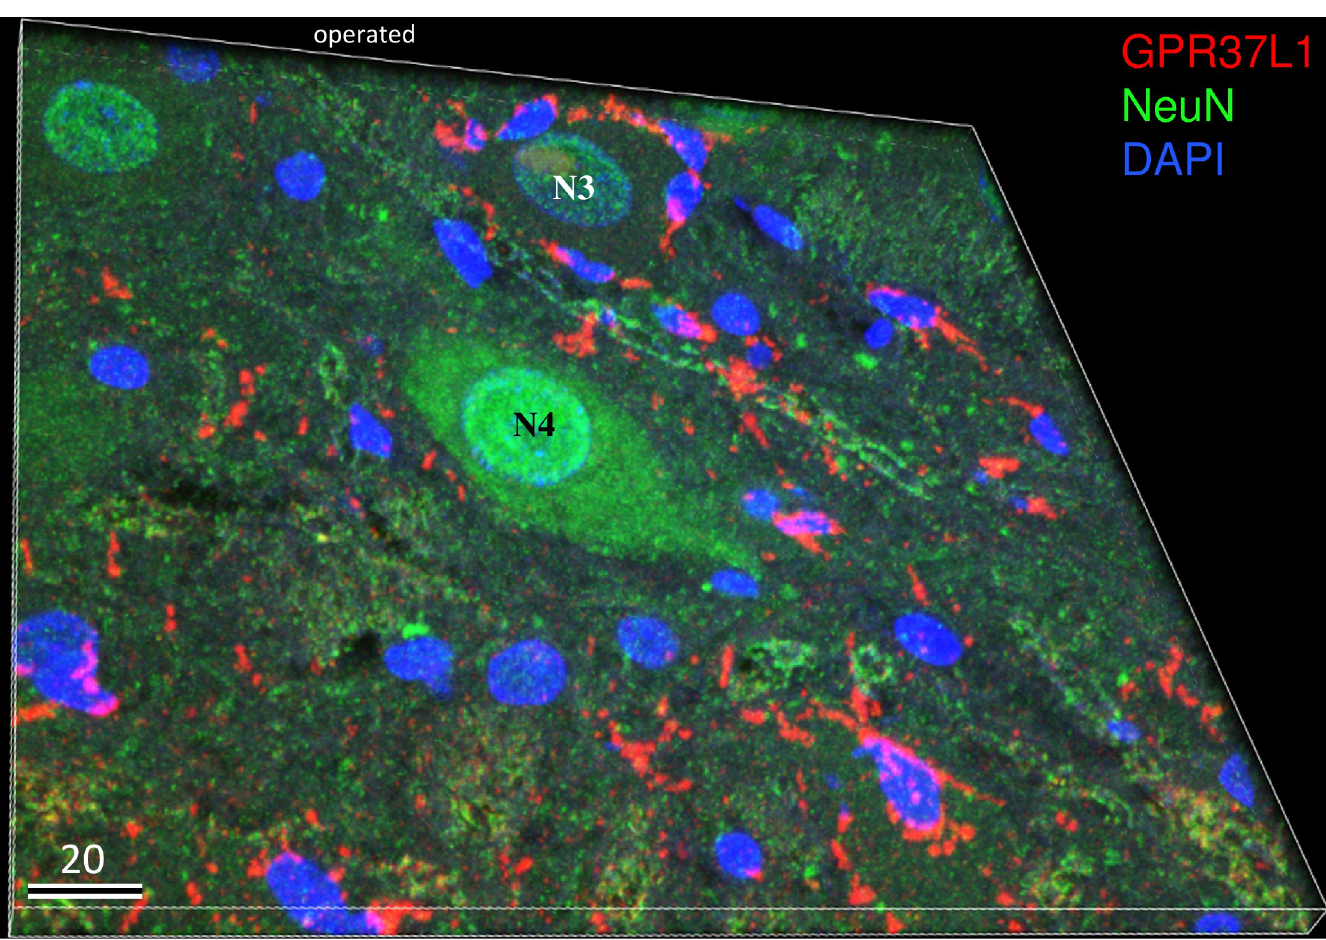
Fig 7. Three-dimensional image of triple-staining with GPR37L1 (red), NeuN (green), and DAPI (blue) on the operated side 7 days after facial nerve transection. GPR37L1-IR was observed in the cell bodies of microglia-like small cells. GPR37L1 co-localization with NeuN was not as prominent in the neurons as in the small cells around the neurons. Note that the neurons in the center of figure with a strong NeuN-IR signal were not surrounded by GPR37L1-IR cells, but the neuron in the upper side of the figure with a faint NeuN-IR signal was surrounded by small GPR37L1-IR cells. The numbers on the bars indicate the scale in microns.